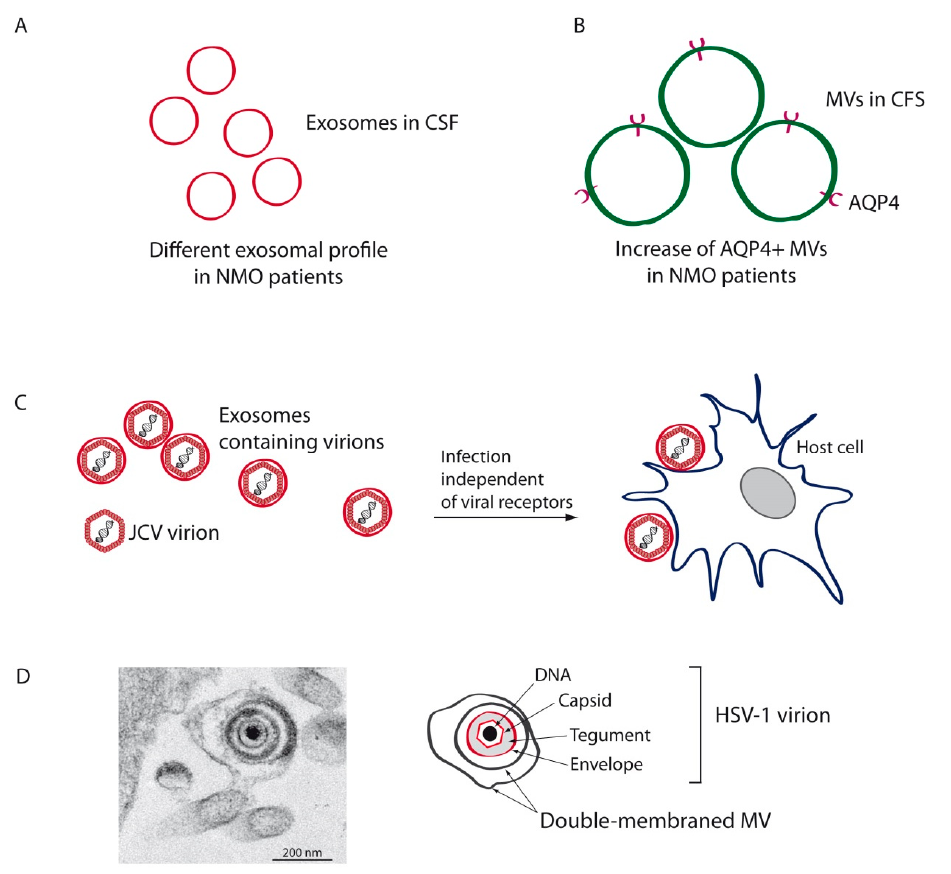
Figure 3. Schematic diagrams depicting the implication of EVs in other CNS demyelinating diseases. Analysis of the CSF of neuromyelitis optica (NMO) patients has shown a distinct exosomal profile ( A ) and an increase in astrocytic aquaporin-4 (AQP4)-positive microvesicles (MVs) ( B ) in these patients compared to healthy controls. ( C ) JCV, the virus associated with the etiology of progressive multifocal leukoencephalopathy (PML), may be secreted enclosed in exosomes that can infect target cells independently of viral receptors. ( D ) Herpes simplex virus type 1 (HSV-1), another virus implicated in demyelination, may also be spread enclosed in MVs. Transmission electron micrograph shows a HSV-1 virion enclosed in a double-membraned MV, and is thus covered by three lipid membrane layers.